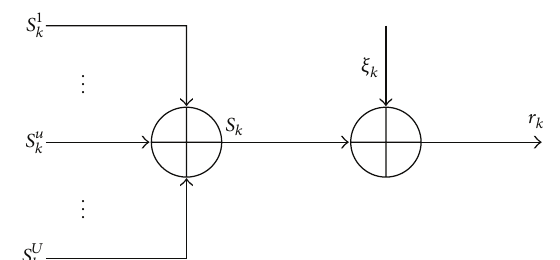
Figure 1: 𝑈 users through Additive White Gaussian Noise (AWGN) channel.